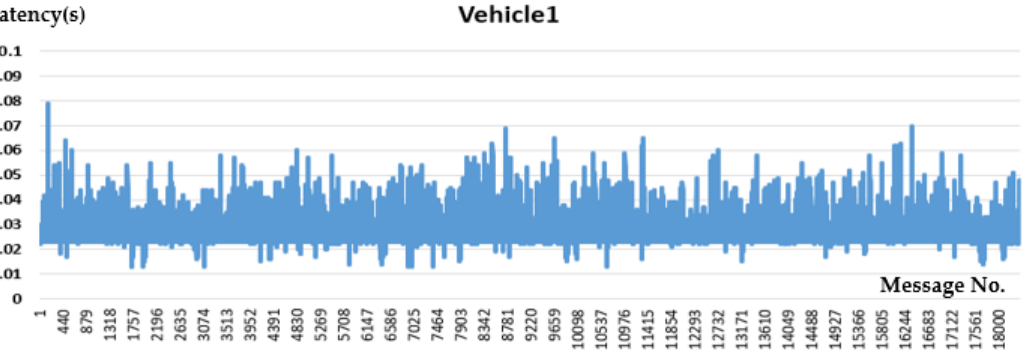
Figure 10. Vehicle1